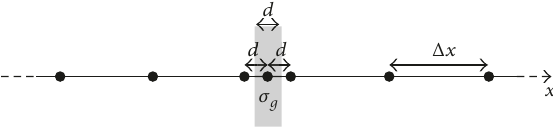
Figure 4: Discretization along the 𝑥 -axis. The vacuum part of the grid is uniformly discretized with step Δ𝑥 ≈ 27 𝜇 m. The graphene sheet is approximated by two small UCHIE cells of size 𝑑 = 1 nm. The graphene conductivity 𝜎 𝑔 = 6.7 S /𝜇 m is solely assigned to the single discretization point enclosed by these two small cells and does not need to be averaged as is the case for the conventional Yee